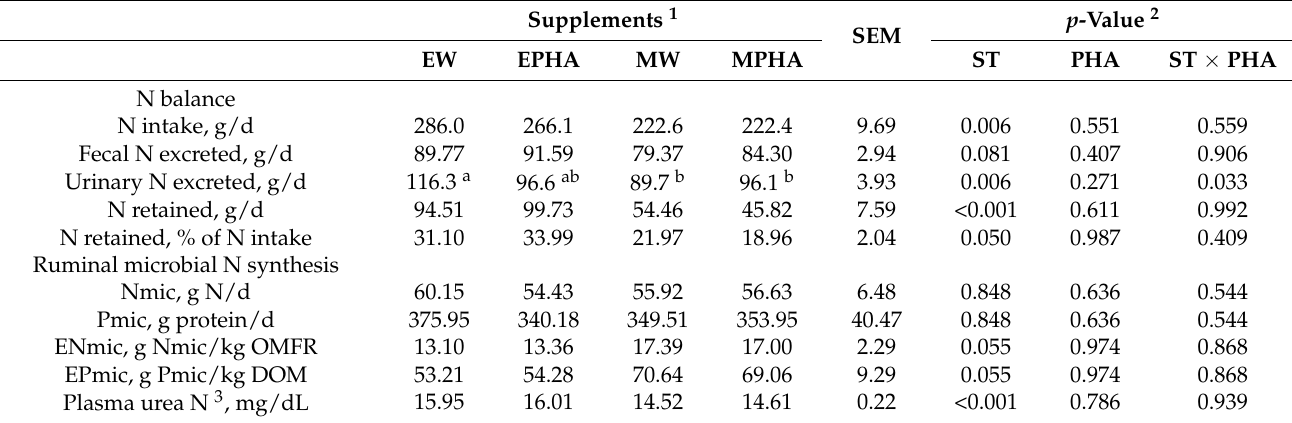
Table 3. Effect of phytogenic compounds in mineral or energy supplementation on nitrogen balance Table 4. Effect of phytogenic compounds in mineral or energy supplementation on ruminal fermen-